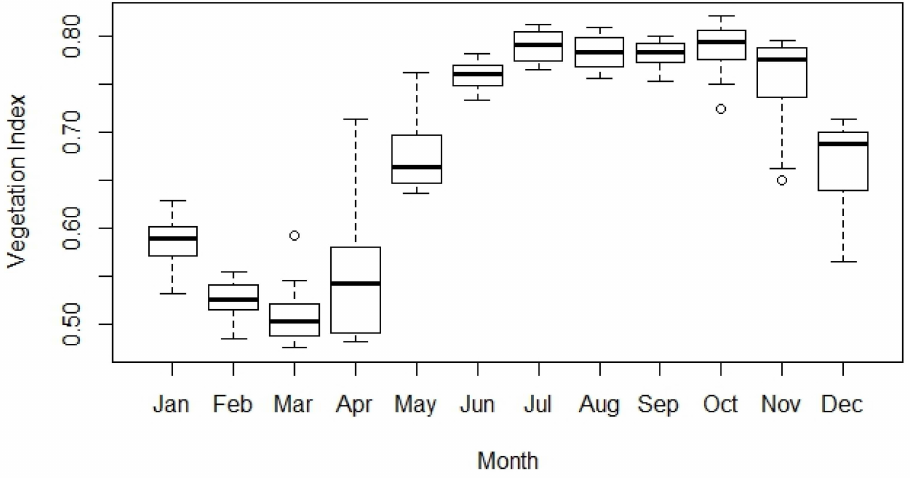
Figure 7. Monthly boxplot of vegetation index in El Salvador between 2001 and